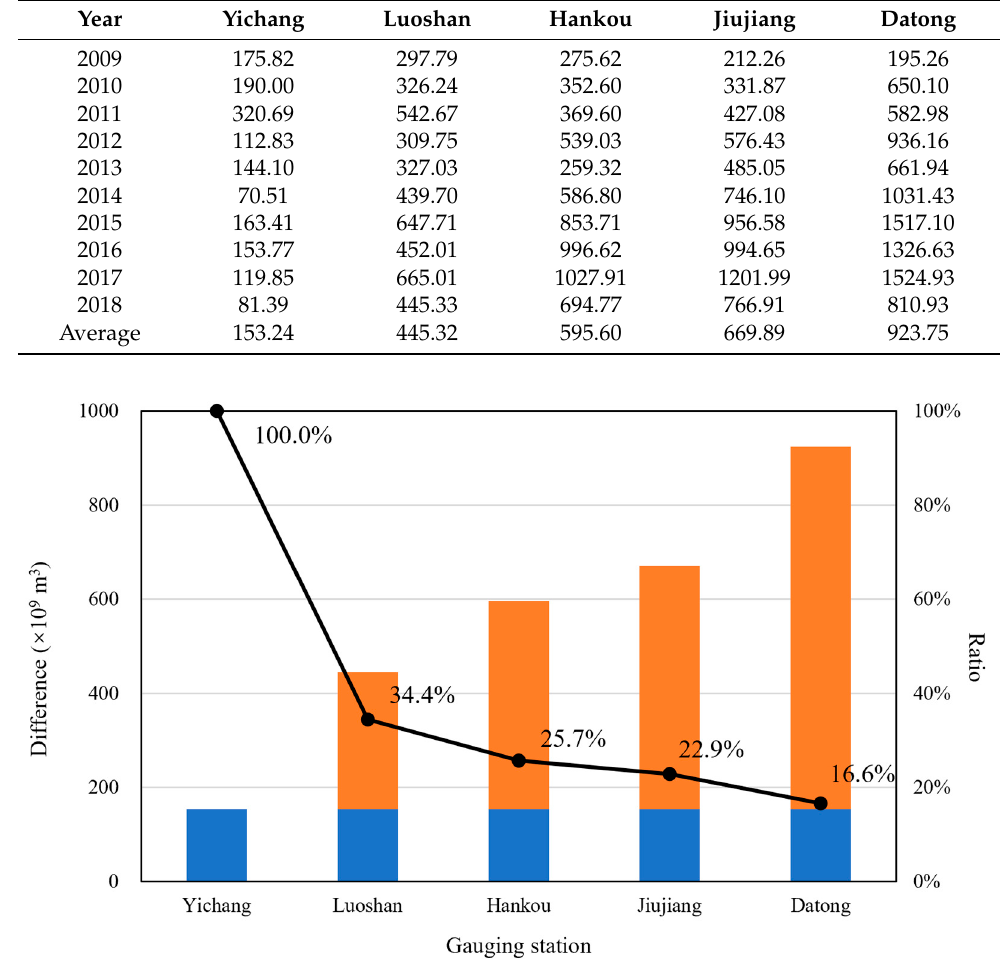
Table 6. The difference between the observed flood season runoff and the reconstructed flood season runoff after the full operation of the TGD from 2009 to 2018. If the difference is less than 0, the TGD has increased the flood season runoff. Difference = R Re − R Ob ; R Re : reconstructed flood season runoff; R Ob : observed flood season runoff.